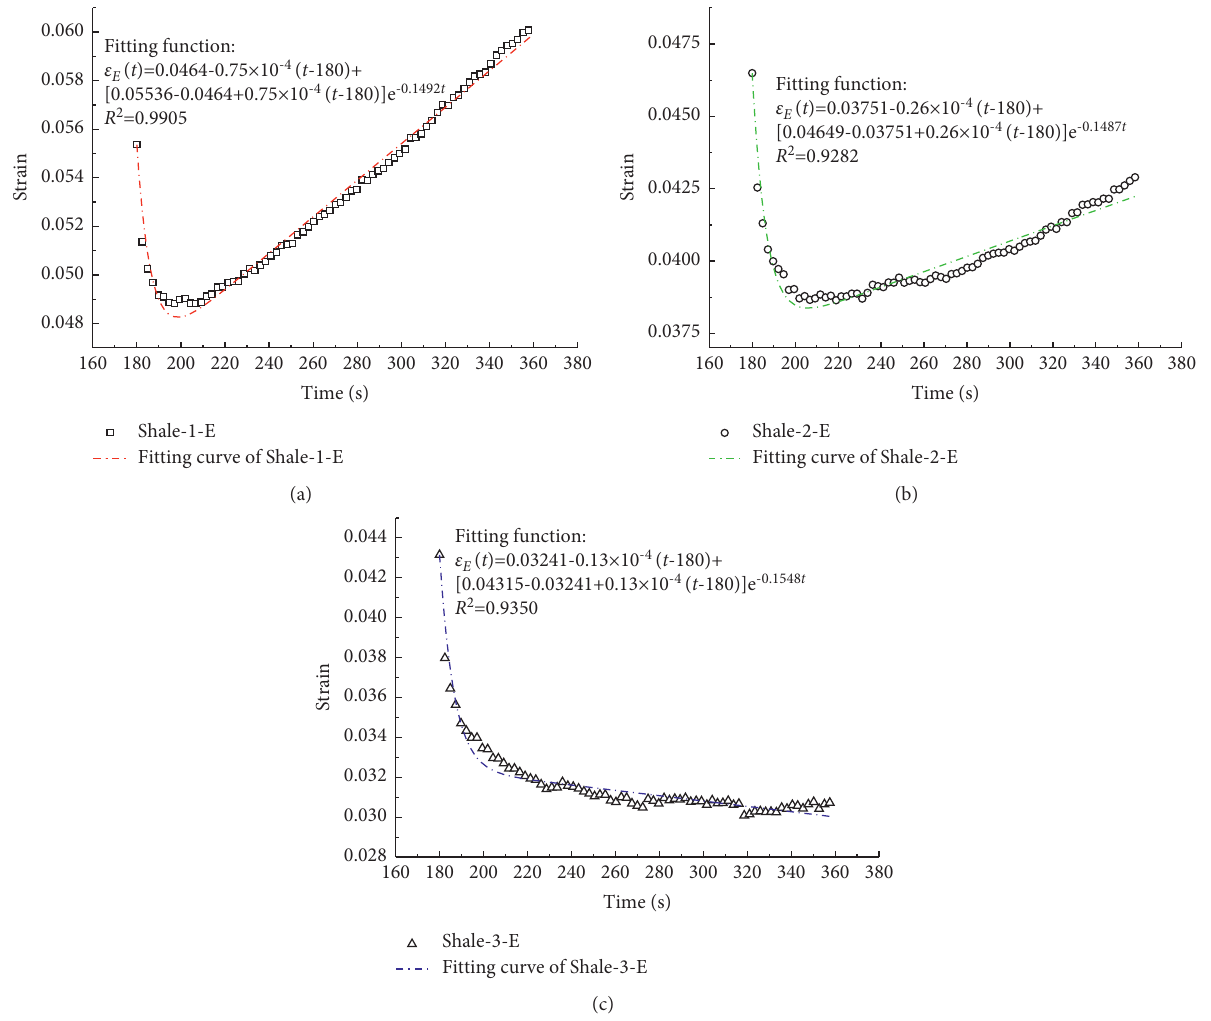
Figure 6: Fitting results of elastic aftereffect curves of (a) shale-1, (b) shale-2, and (c) shale-3 by using the elastic aftereffect equation of the simplified Burgers model.